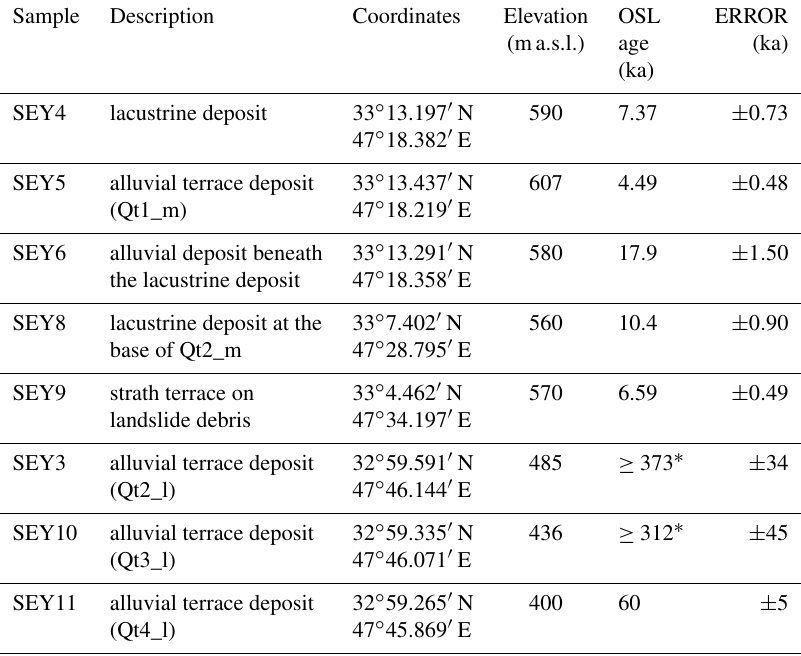
Table 1. OSL ages obtained for the geomorphic markers recognized in the Seymareh River valley. Detailed information and photos of sampling sites are available in the supplementary